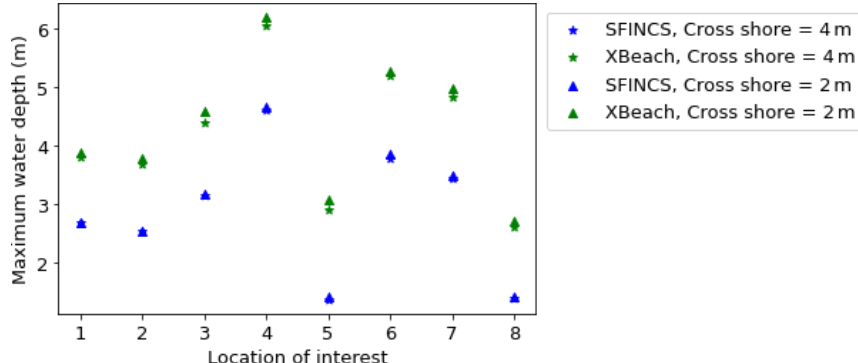
Figure 25. Comparing the maximum water depth achieved at the eight locations of interest using SFINCS and XBeach at two different resolutions, for the Myrtle Beach test case. A maximum tide height of h tide = 4 . 97m is used in all simulations.